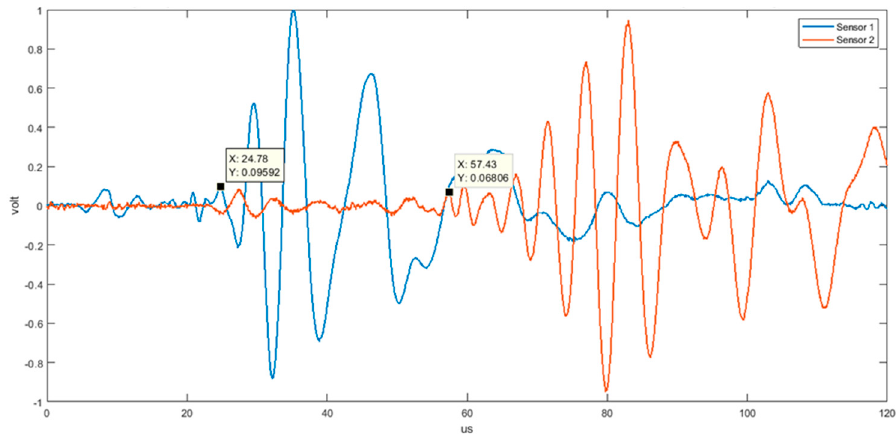
Figure 9. Impact generated signals with a sphere on an aluminum laminate and detected at 10 cm and 20 cm distance from the impact point with PI sensors—analog filtered signals.